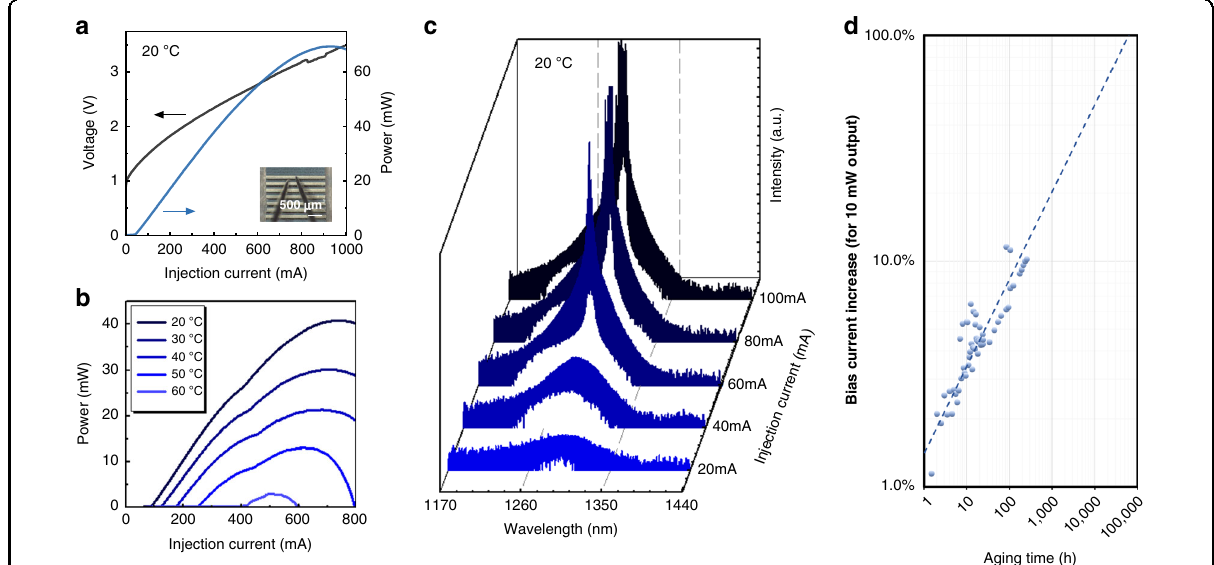
Fig. 5 Laser measurement results. a Room-temperature LIV of the device with the highest output power. Inset shows the probe needles on a cleaved laser bar. b Temperature-dependent LIV shows lasing up to 60 °C. c Lasing spectrum as a function of injection current at room temperature. d Aging results for the in-pocket laser at 35